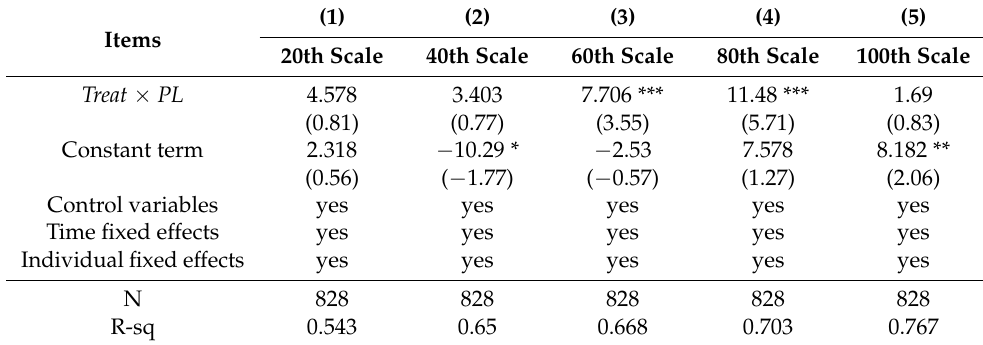
Table 8. CER estimation results of different corporate